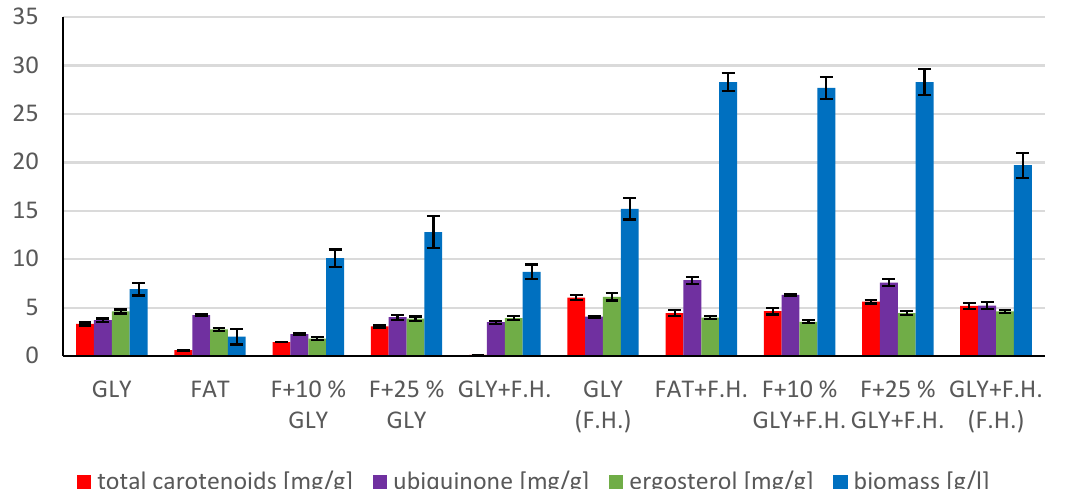
Figure 13. Metabolite production by biomass of yeast strain Rhodotorula mucilaginosa CCY19-4-25 in conditions of C/N ratio 50.